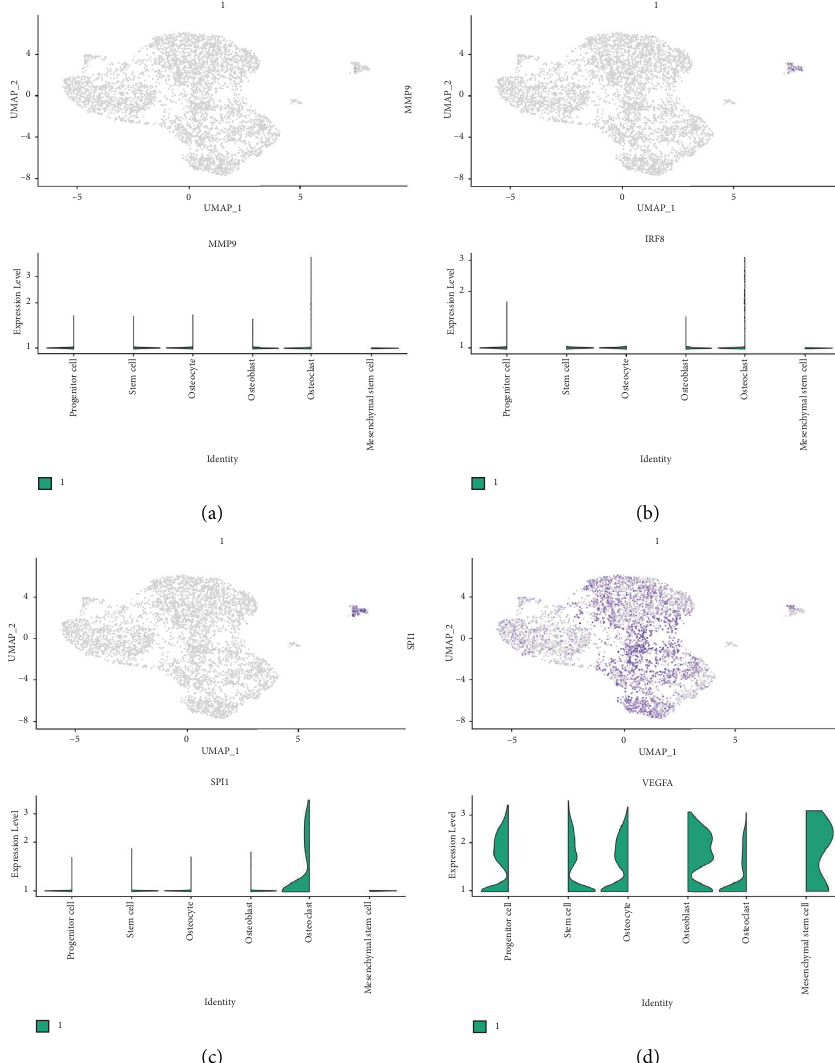
Figure 5: (a) Te single-cell RNA sequencing analysis of MMP9. (b) Te single-cell RNA sequencing analysis of IRF8. (c) Te single-cell RNA sequencing analysis of SPI1. (d) Te single-cell RNA sequencing analysis of